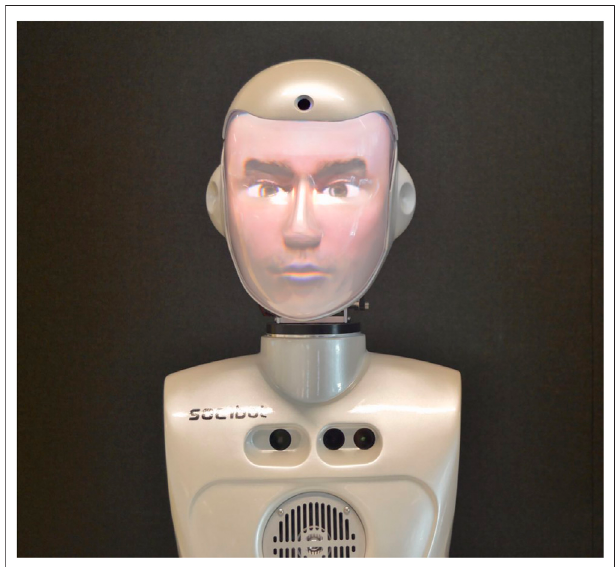
FIGURE 1 | The SocibotMini robot used in the current